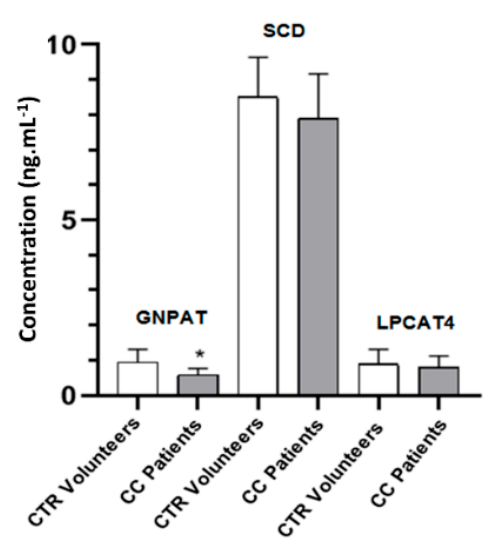
Figure 5. In vitro quantitative measurement of plasmalogen synthesis enzymes. Glyceronephosphate O-acyltransferase (GNPAT), stearoyl-CoA desaturase 1 (SCD) and lysophosphatidylcholine acyltransferase 4 (LPCAT4) concentrations in plasma samples from colon cancer (CC) patients and control (CTR) volunteers. Values expressed as mean ± standard deviation * p < 0.05.